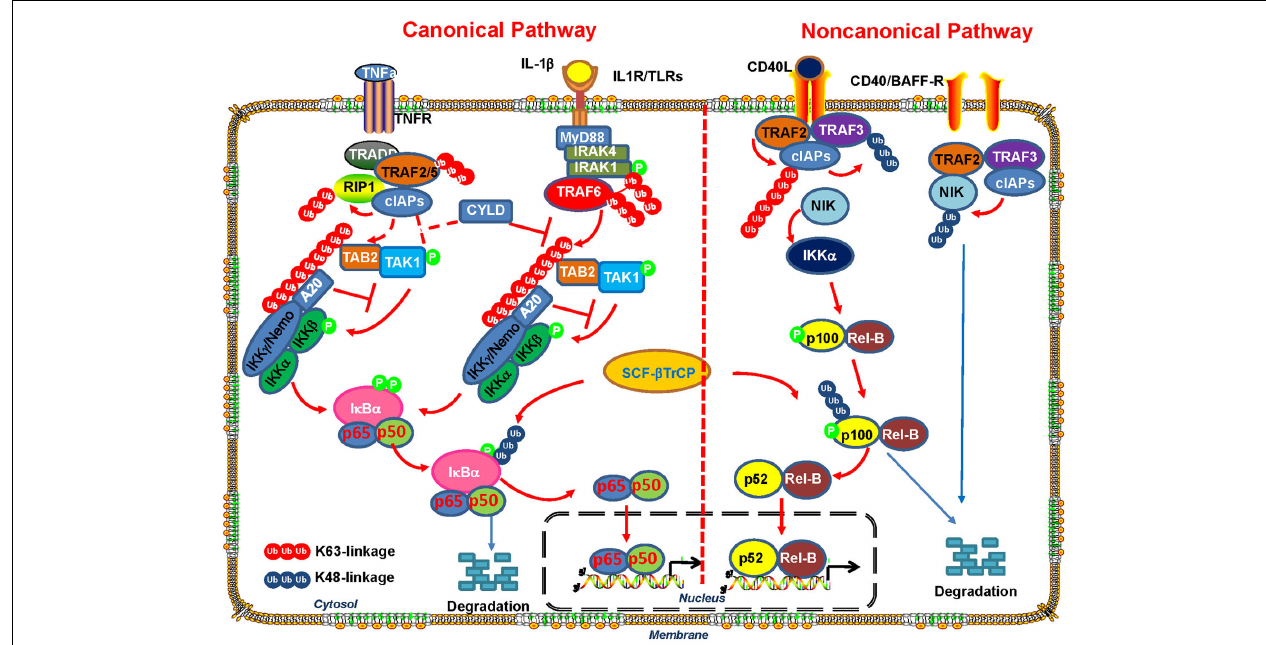
phosphorylates and activates IKK- β to induce NF- κ B activation. In the non-canonical pathway,TRAF3,TRAF2, and cIAP promote rapid proteasomal degradation of NIK by the ubiquitin–proteasome system under un-stimulated condition.Various stimuli release NIK fromTRAF3 inhibition by triggering cIAP activation byTRAF2-mediated K63-polyubiquitination and subsequent degradation ofTRAF3. NIK-mediated-phosphorylation of p100 and its subsequent processing promotes RelB/p52 nuclear translocation and NF- κ B